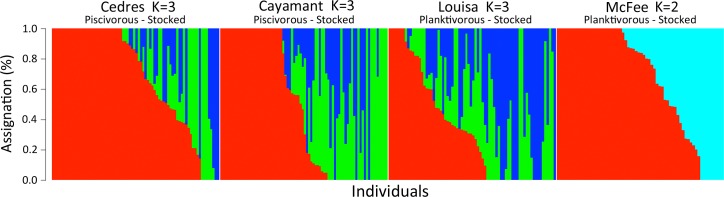
Admixture vertical plots for each stocked population.Vertical bars represent an individual and each different color corresponds to its assignment to one of the clusters (genetic ancestry): proportion of local ancestry (red), Blue Sea Lake (blue), Lake Trente et Un Milles (green) and Blue Sea in McFee Lake (aqua).